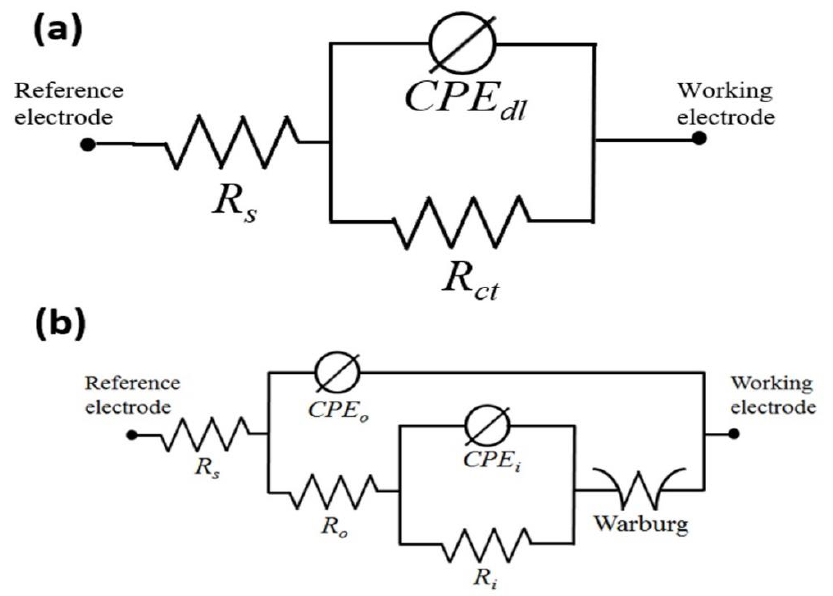
Figure 9. The equivalent circuit models, which are used to interpret the impedance responses of the ( a ) titanium substrate and ( b ) the coatings obtained in Baths A and B.